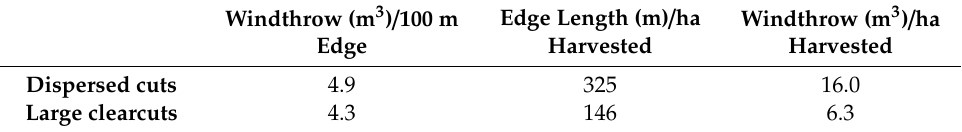
Table 1. Synthesis of wind damage for two di ff erent clearcutting patterns in balsam fir stands [30].